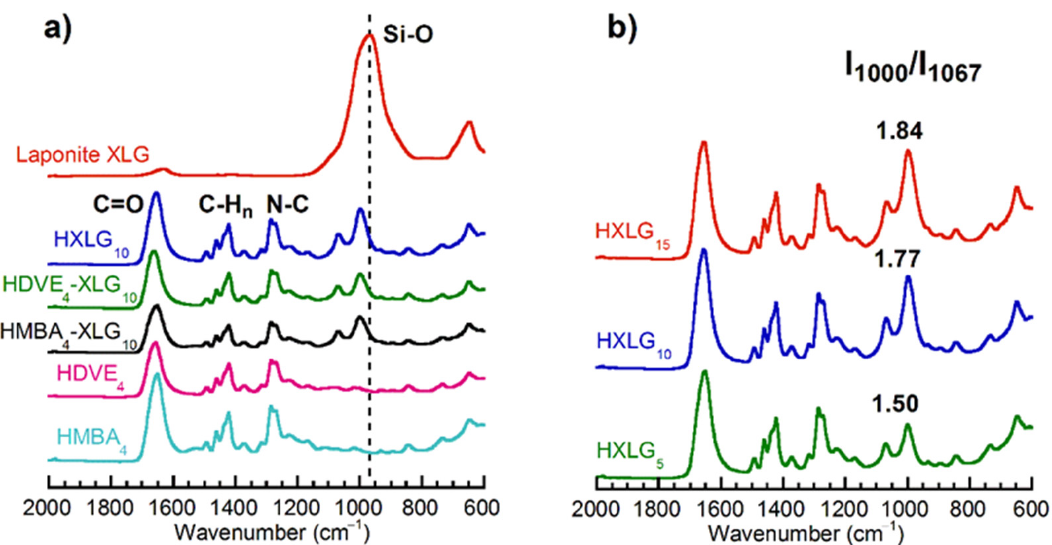
Figure 4. FTIR spectra of the hydrogels synthesized. ( a ) Hydrogels crosslinked with XLG and/or MBA/DVE; ( b ) NC hydrogels crosslinked with various amounts of XLG. I 1000 /I 1067 is the ratio of the intensities (height) of the bands at 1000 cm − 1 and 1067 cm − 1 .